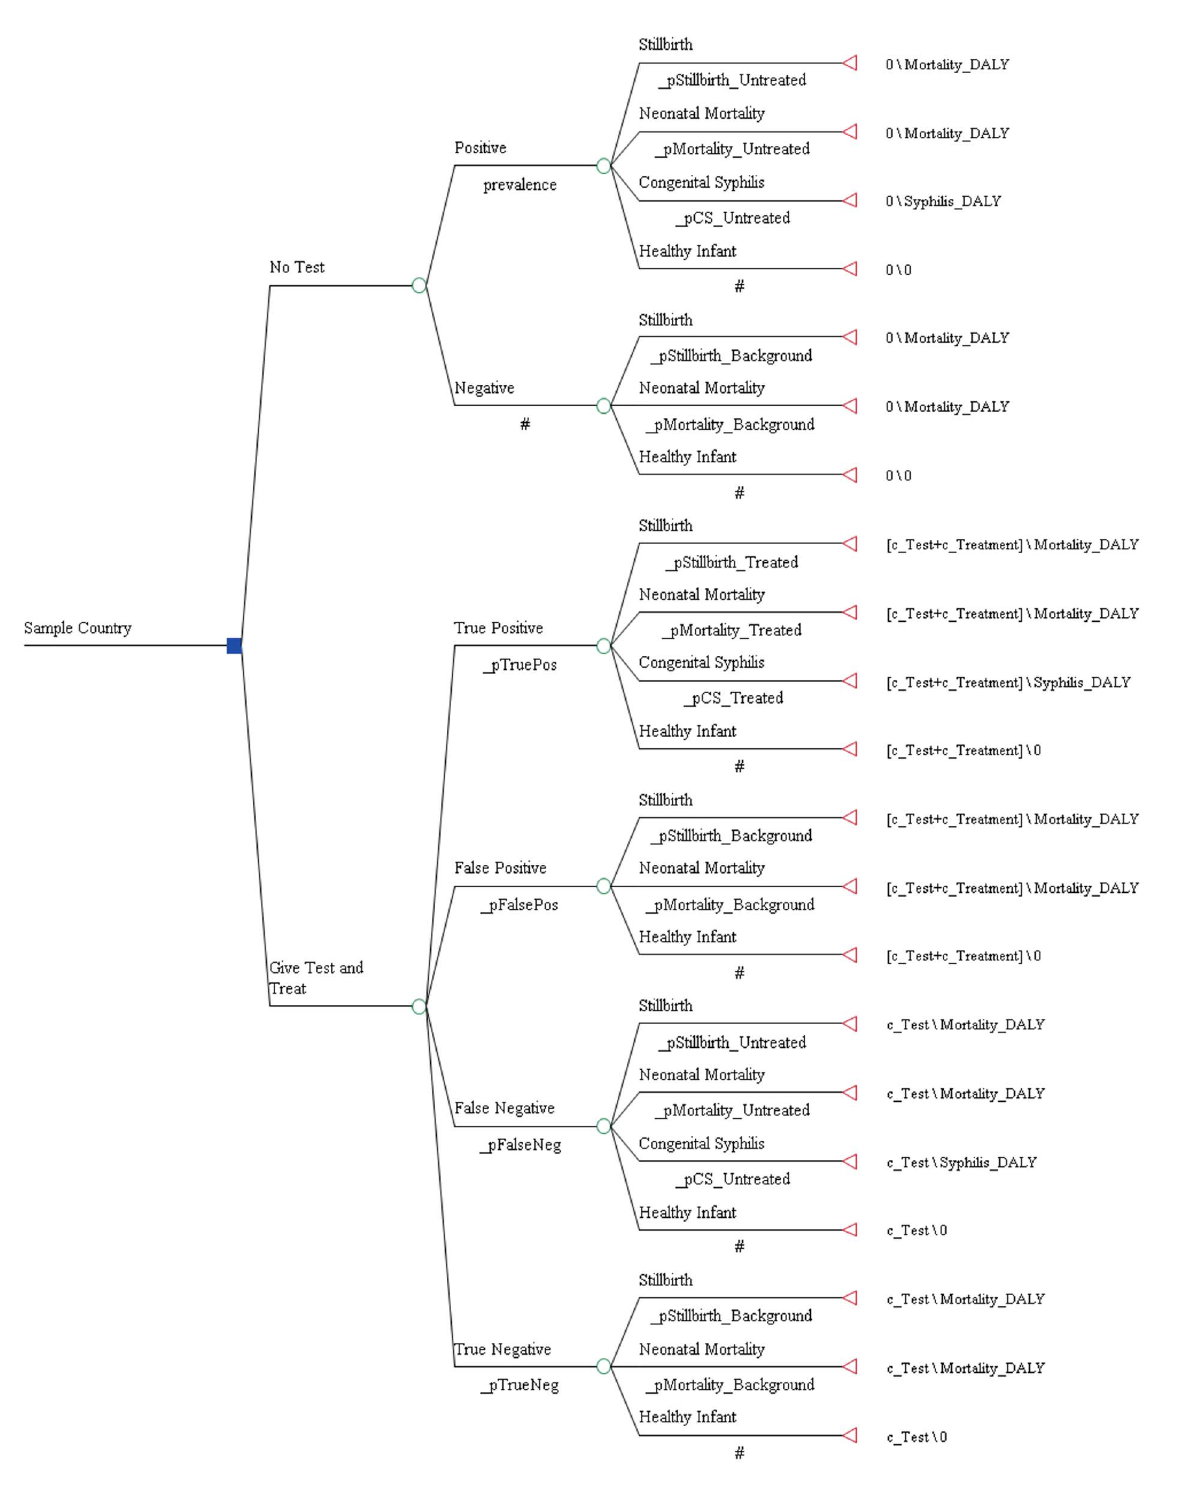
Figure 1. Decision tree.